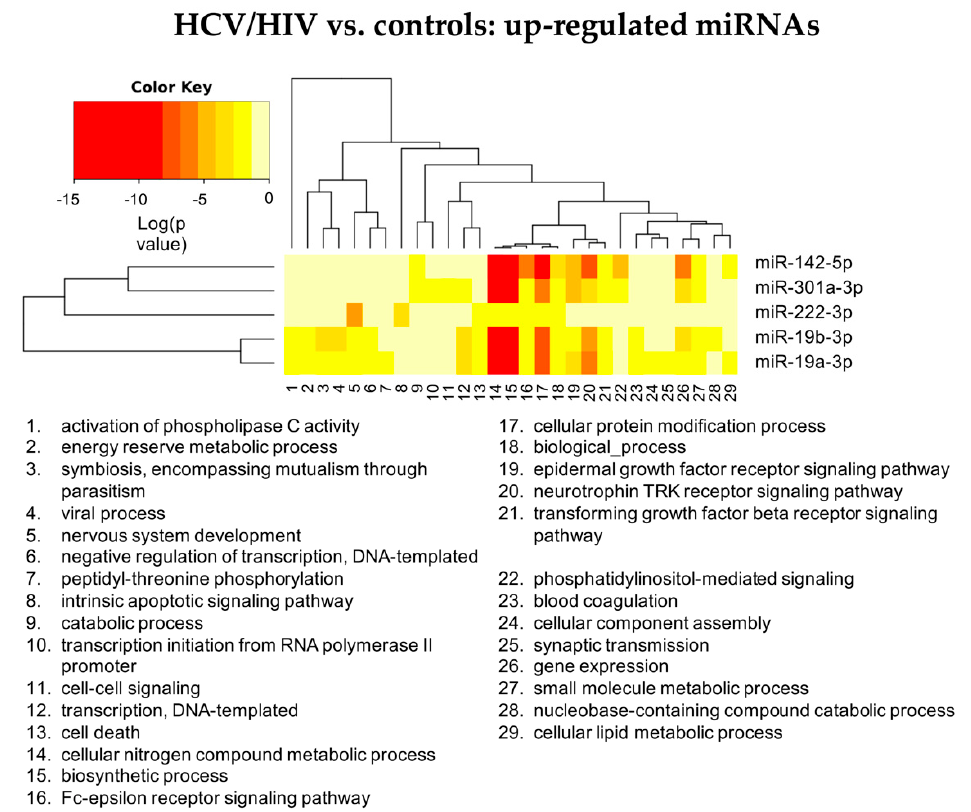
Figure 5. Heatmap showing the significance (see color key) of the association of up-regulated miRNAs with “Gene Ontology-Biological Process” categories, as identified applying the “Categories Union” method.